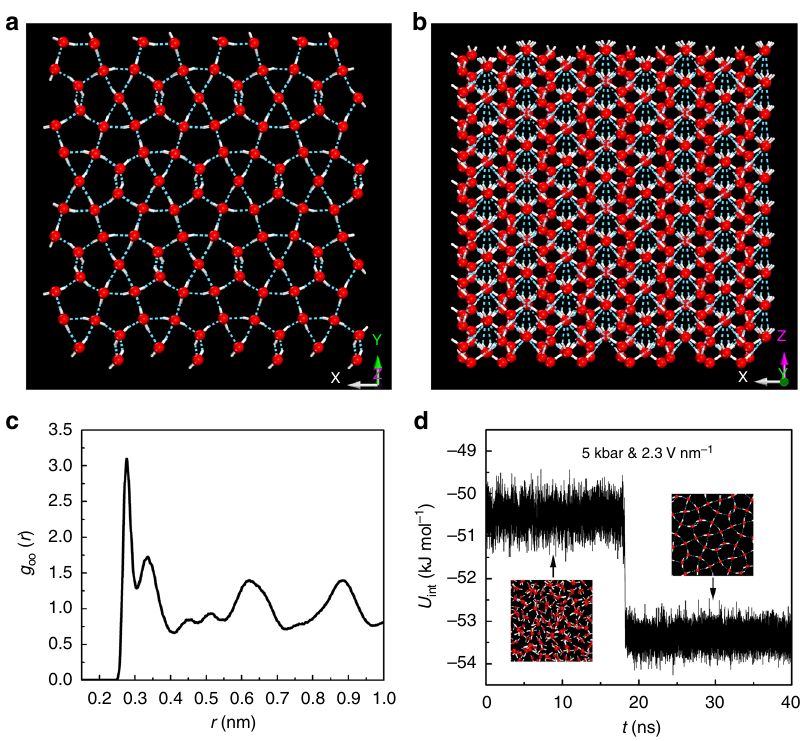
Fig. 1 Room-temperature electrofreezing of liquid water. Snapshots of ice χ obtained at T = 270 K and E = 2.3 V nm − 1 : view in the ( a ) z -axis and ( b ) y -axis direction. c Computed radial distribution function (RDF) of oxygen atoms for ice χ . d Time-dependent potential energy per water molecule for the system at P = 5 kbar, T = 270 K, and E = 2.3 V nm − 1 . Oxygen atoms are depicted as red balls, hydrogen atoms as white sticks, and hydrogen bonds as blue